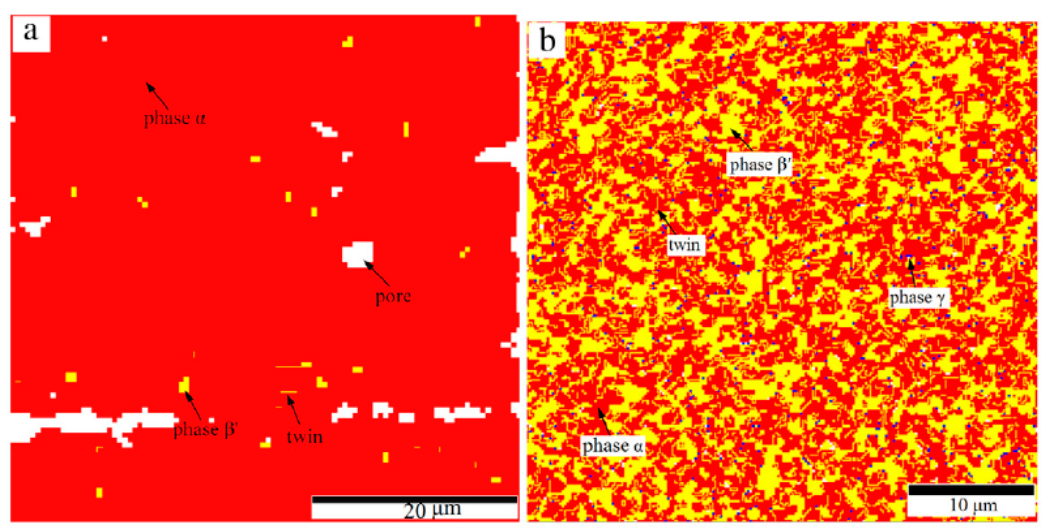
Figure 7. EBSD phase mappings of ( a ) as-sprayed and ( b ) friction-stirred Cu-Zn alloy coatings, where the red, yellow and blue colors are corresponding to the phases of α (Cu 3 Zn), β′ (CuZn) and γ (Cu 5 Zn 8 ), respectively (adapted from reference [59] , with permission from © Elsevier).